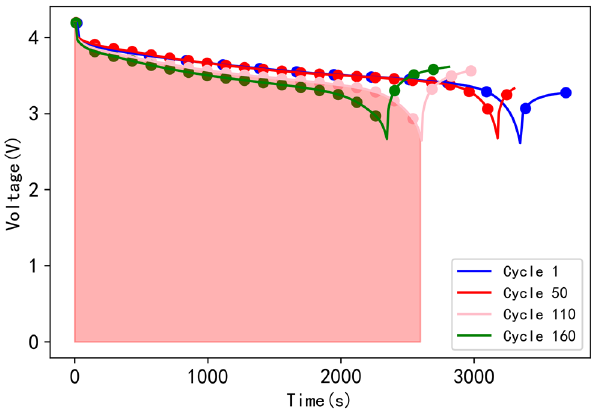
Figure 4. Discharge voltage change curves in different cycles of the B5 battery.